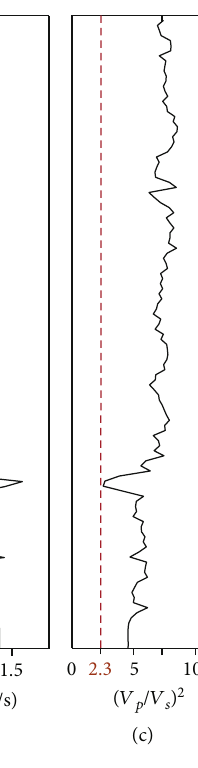
Figure 8: Well logging curves. (a) indicates P-wave velocity; (b) indicates S-wave velocity; (c) indicates ð V P / V S Þ 2 sat